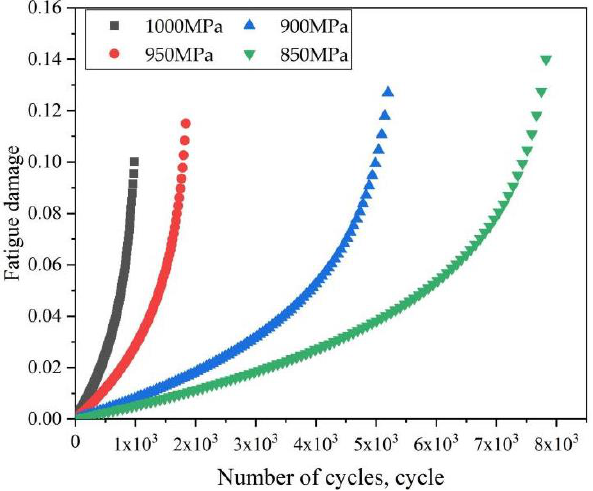
Figure 17 . Fatigue damage evolution under the different maximum stress. Figure 17. Fatigue damage evolution under the different maximum